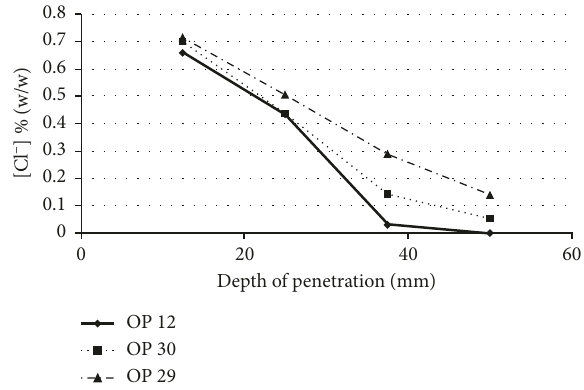
Figure 3: Results for chloride ingress versus depth from exposed surface OPC.